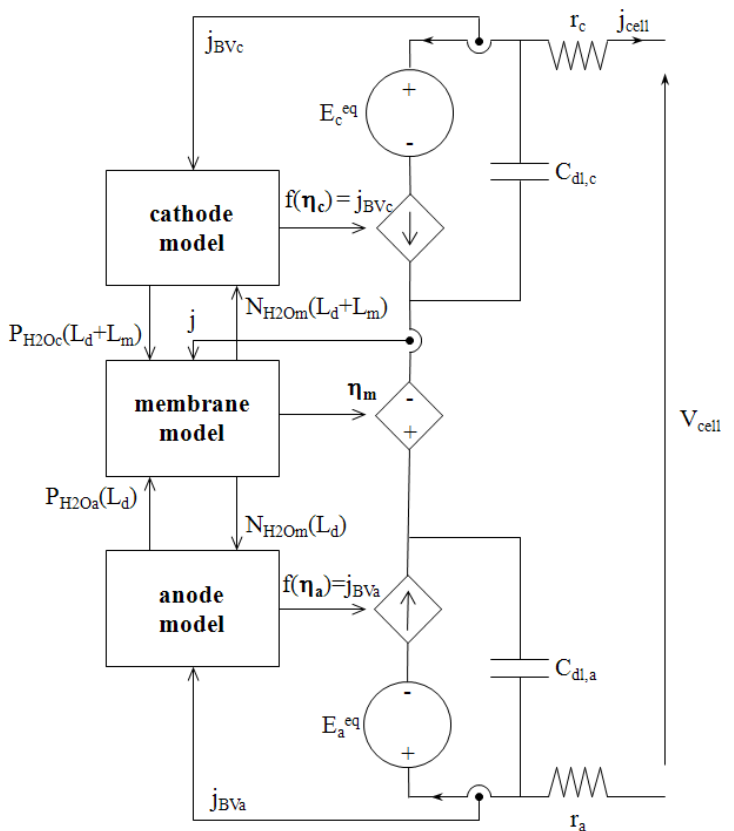
Figure 8. Electrical circuit model of a single cell.